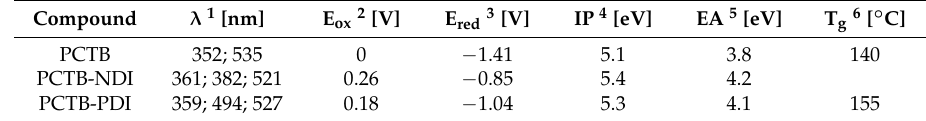
Table 1. The summary of photophysical, electrochemical, and thermal properties.